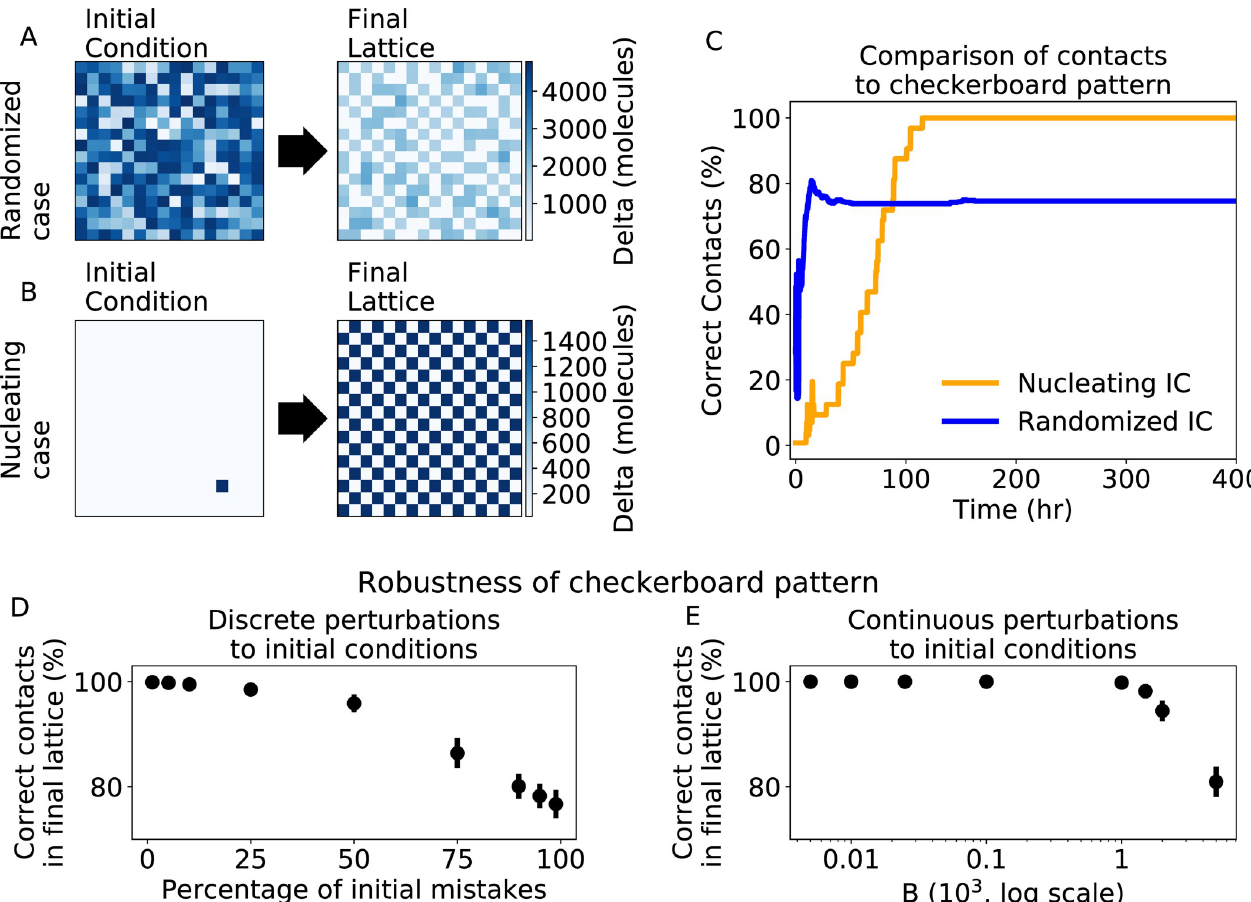
Fig 2. Patterning disorder in the noise-free multicell model. (a) the initial (left) and final (right) patterns starting from randomized initial conditions. The blue heatmap quantifies the cellular levels of Delta. (b) Same as (a) for a “nucleating” initial condition. (c) The percent of correct contacts as a function of time for the randomized initial conditions (blue) and the nucleating initial condition (orange) corresponding to panels (a) and(b). The lattice with randomized initial condition leads to a frustrated pattern. (d) The average percent of correct contacts as a function of percentage of mistakes in the initial checkerboard pattern. (e) The average percent of correct contacts as a function of B, the amplitude of the lattice perturbation normalized by 10 3 (the magnitude of Notch and Delta copy numbers). For panels (d)-(e), percentages of correct contacts are calculated upon full equilibration and averaged over 20 independent simulations. The checkerboard pattern is robust for up to a quarter of mistakes in the lattice or a perturbation of magnitude 10 3 molecules, comparable to the Notch and Delta copy